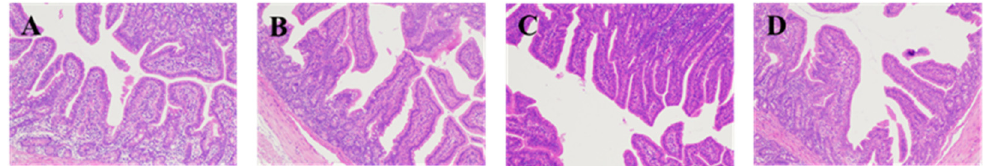
Figure 2. Effects of protease supplementation on jejunal morphology of weaned piglets: ( A ) the control group; ( B ) adding 150 mg/kg protease; ( C ) adding 300 mg/kg protease; ( D ) adding 300 mg/kg protease.